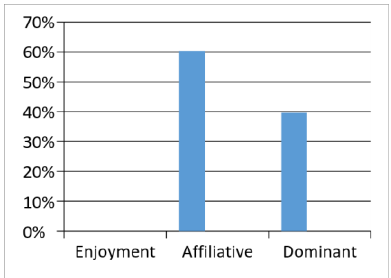
Figure 3. Perception of agent’s